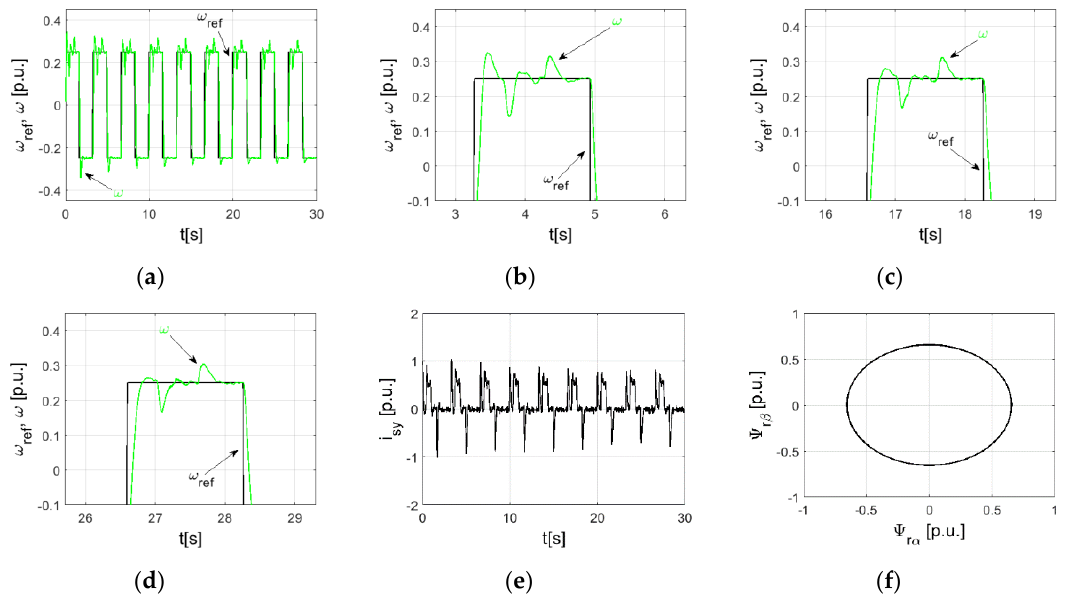
Figure 11. Transients of state variables—speed ( a – d ), component of current ( e ) and hodograph of the rotor flux vector ( f ) observed in the DFOC structure with PI speed controller with neural compensation: load switching.